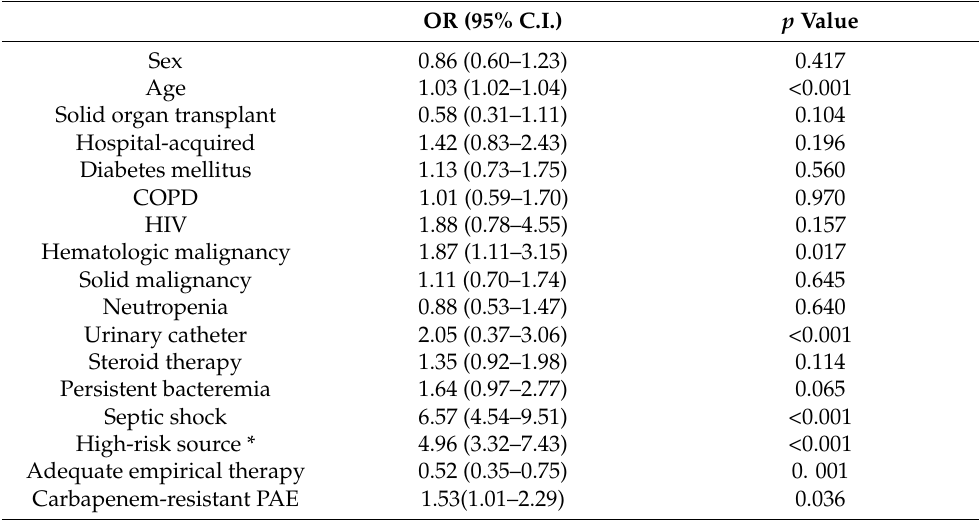
Table 3. Logistic regression model of variables evaluated as predictive factors of mortality in patients presenting with Pseudomonas aeruginosa bloodstream infections.